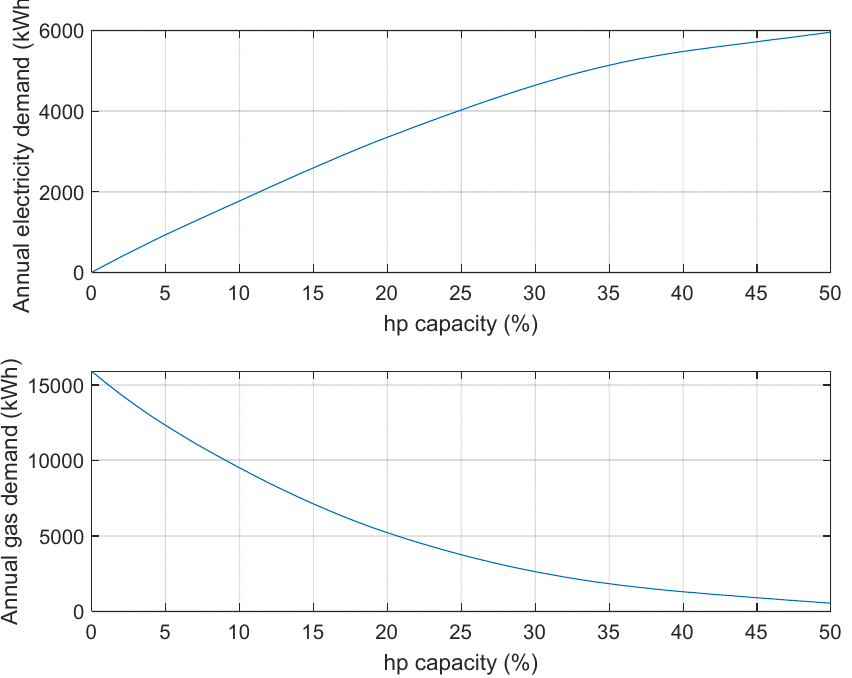
Figure 7. Annual electricity and gas demand for varying size of heat pump, OXF1.